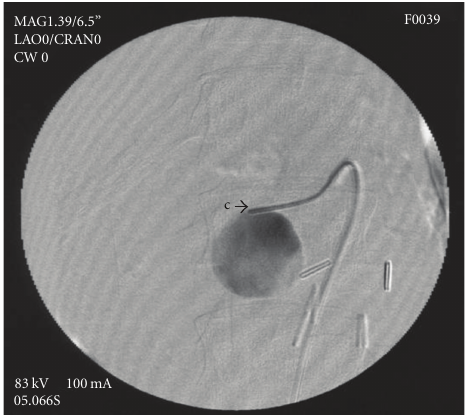
Figure 4: Superselective angiography through the feeding artery (aneurysmography), showing no vessels arising from pseudoa-